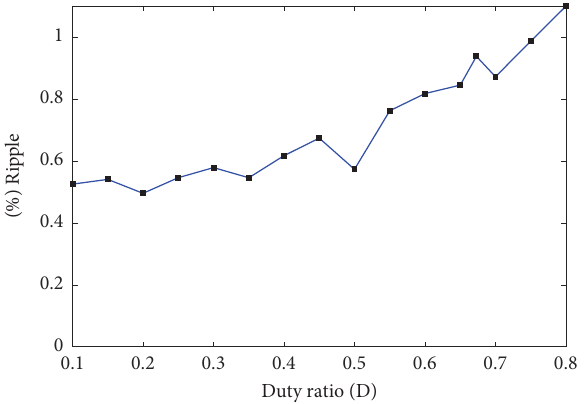
Figure 23: Plot of output ripple voltage (%) for various duty ratios ( D ). Table 5: Performance of the converter under light load conditions.